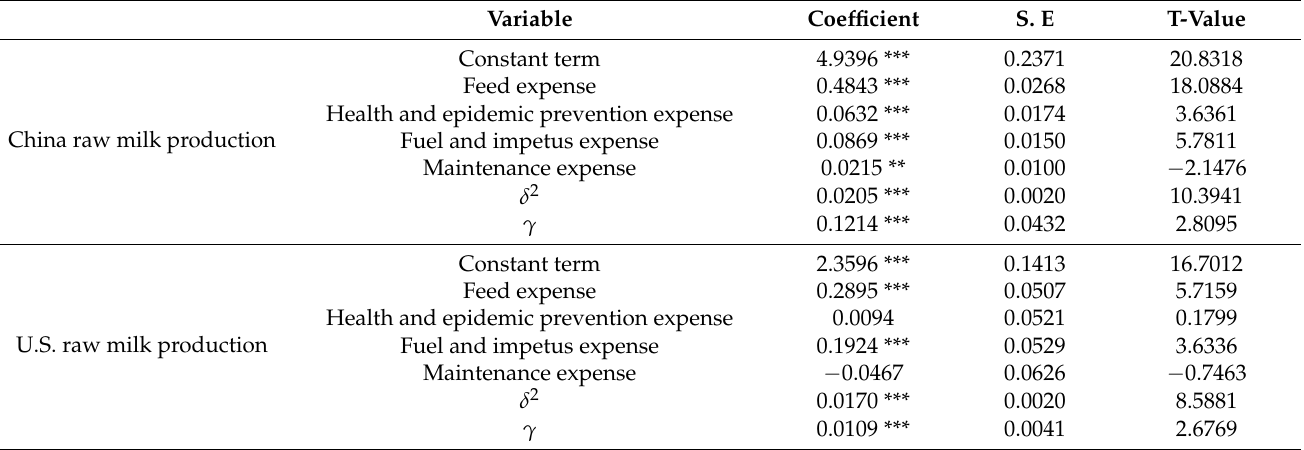
Table 1. Estimation results of the stochastic frontier production